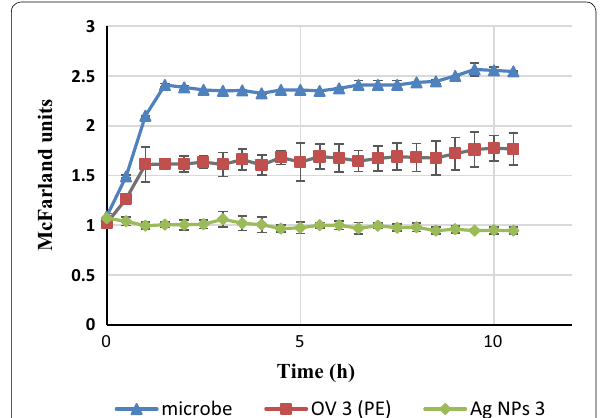
00.511.522.53 Fig. 7 The growth curve of E. coli VKPM-M17 compared with the growth curves of bacteria under the influence of OV 3 and Ag NPs